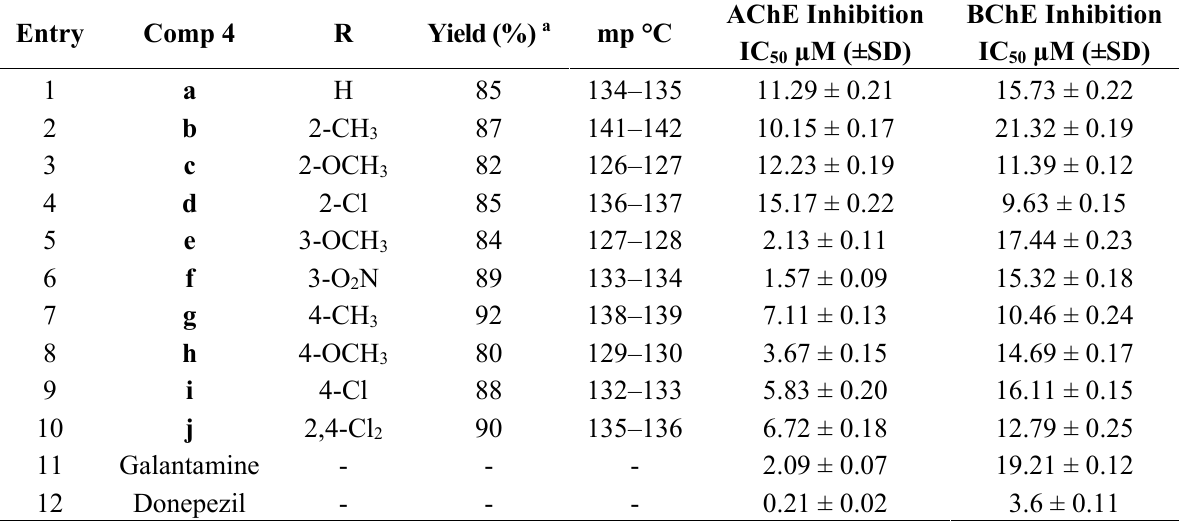
Table 1. Physical data, AChE and BChE inhibitory activities of 4a – j